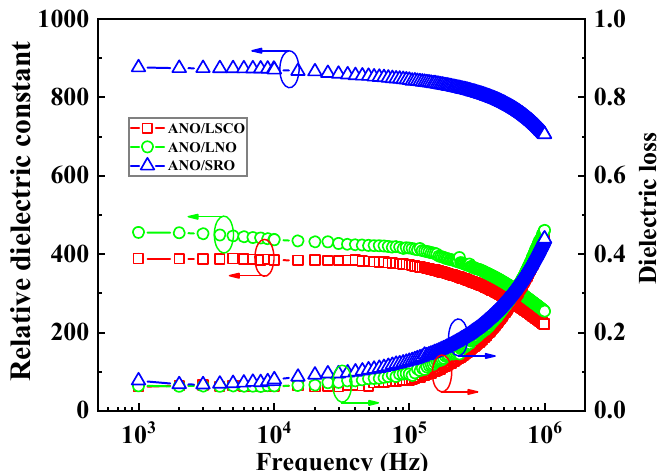
Figure 3. Frequency stability of relative dielectric permittivity and dielectric loss of ANO films grown on LSCO, LNO and SRO bottom electrodes.